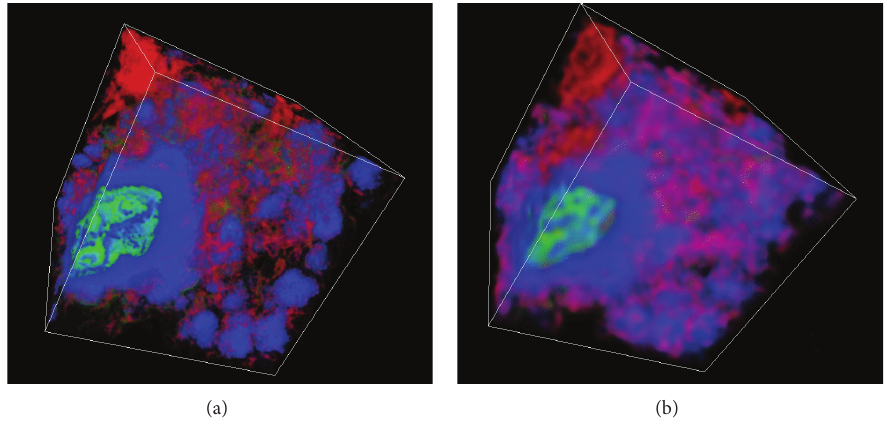
Figure 4: 3D physical structure of Area 1 at different spatial resolutions: (a) at resolution of 3.7 𝜇 m; (b) at resolution of 11.84 𝜇 m. The same colouring scheme is used as in Figure 3. The displayed sample size is 355.2 × 355.2 × 355.2 𝜇 m 3